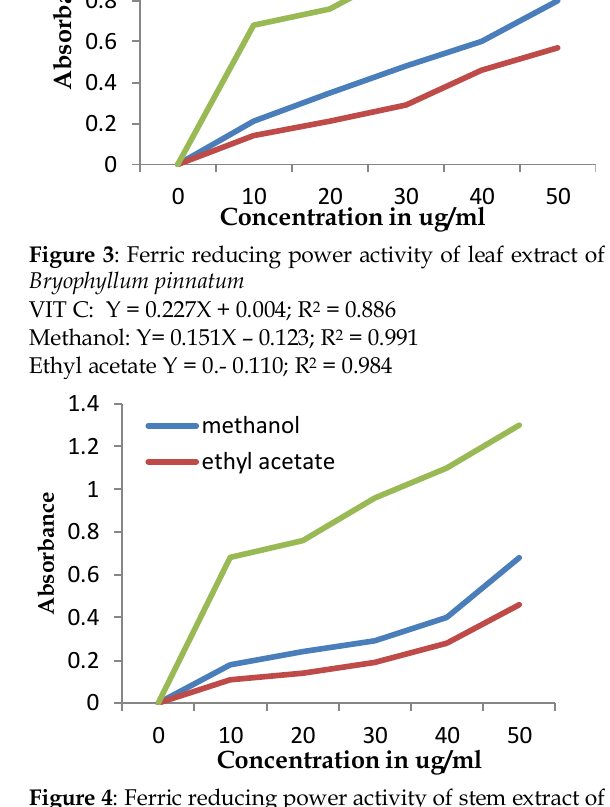
Figure 4 : Ferric reducing power activity of stem extract of Bryophyllum